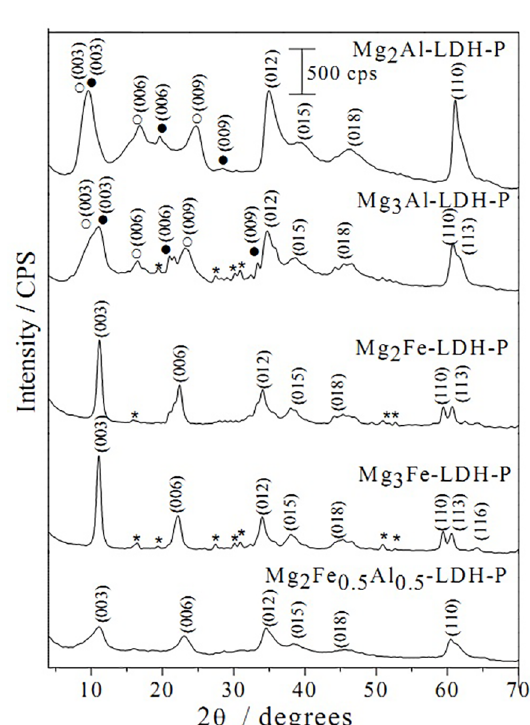
Figure 2. Diffractograms of LDHs after exchange reactions: